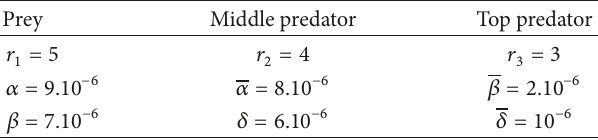
Table 1: Characteristics of the three fish populations. Prey Middle predator Top